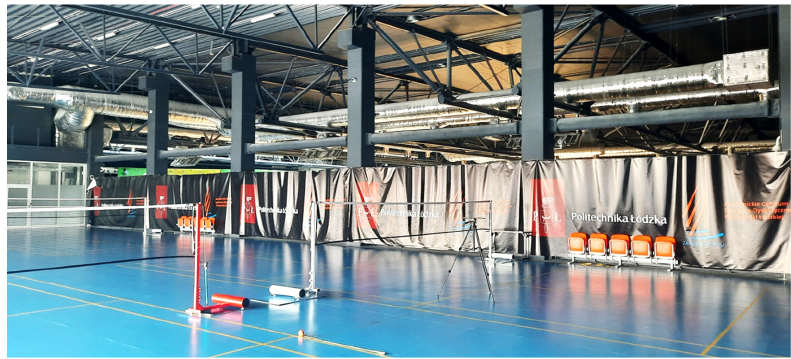
Figure 7. Second test scenario (S2). Photograph showing the indoor environment.